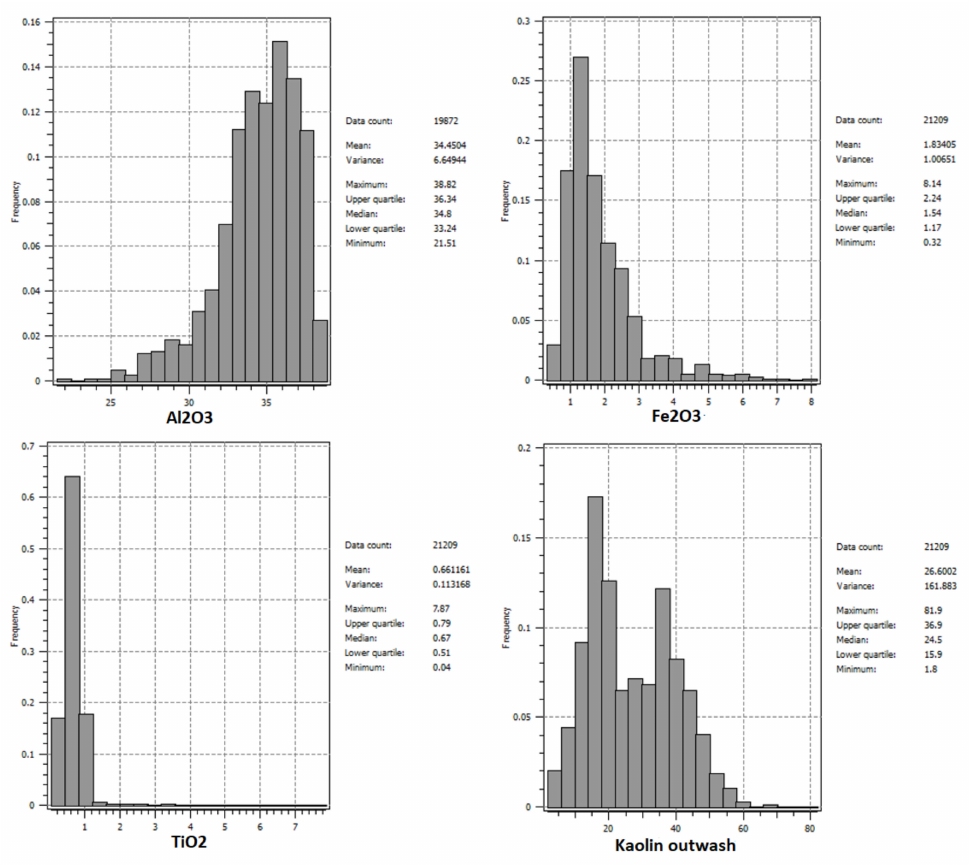
Figure 5. Histogram of frequencies of parameters Al 2 O 3 , Fe 2 O 3 , TiO 2 and kaolin outwash (wt %), and their basic statistical